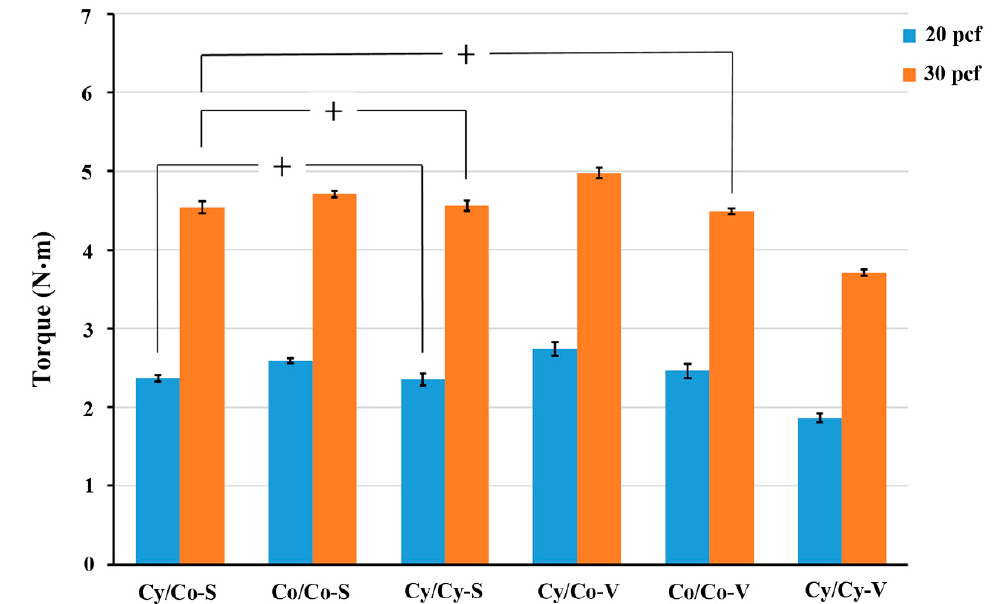
Figure 5. Mean maximal insertion torque for screws of various geometries inserted in a 3.7-mm pilot hole using 20-pcf and 30-pcf test blocks. Groups without significant differences are indicated with the ‘‘+” symbol.